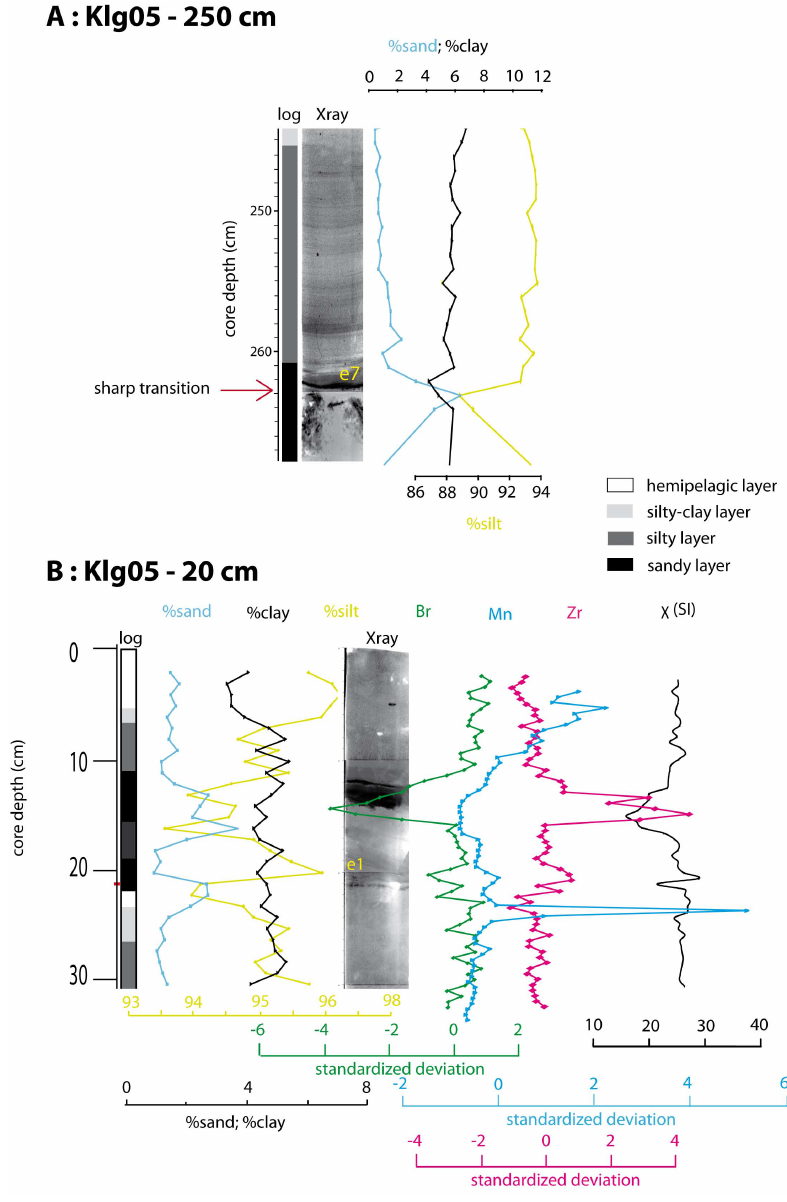
Fig. 2. Typical examples of turbidites: granulometric and geochemical signatures as described in Sect. 5. Turbidites are composed of a basal sandy sublayer, an upper silty sublayer with frequent laminations and a top light grey clayey sublayer. A: X-ray imagery and granulometry zooms of event 7 in Klg05. Yellow label on the X-ray indicates the position of the event as in Fig. 4. B: X-ray imagery, granulometry and geochemical profiles of event 1 in Klg05. Turbidites can have a positive signature in Zirconium (pink curve), negative in bromine (green curve). Manganese (blue curve) typically shows a peak just below turbidites. Yellow names indicate events as referenced in Fig.